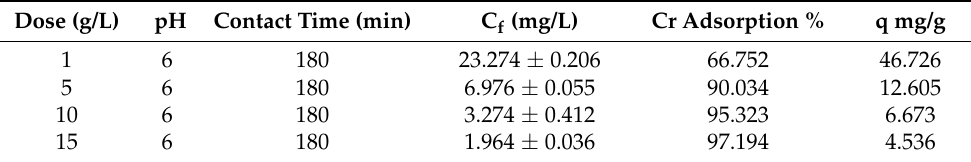
Table 4. Effect of adsorbent dose on Pb 2+ removal efficiency (C o = 70 mg/L, agitation speed = 150